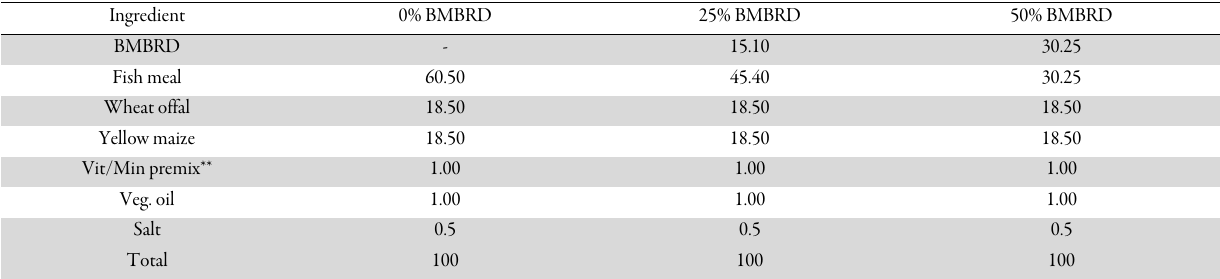
Table 2. Ingredient composition (g/100 g) for the formulated experimental diets Ingredient Fish meal Wheat offal Yellow maize